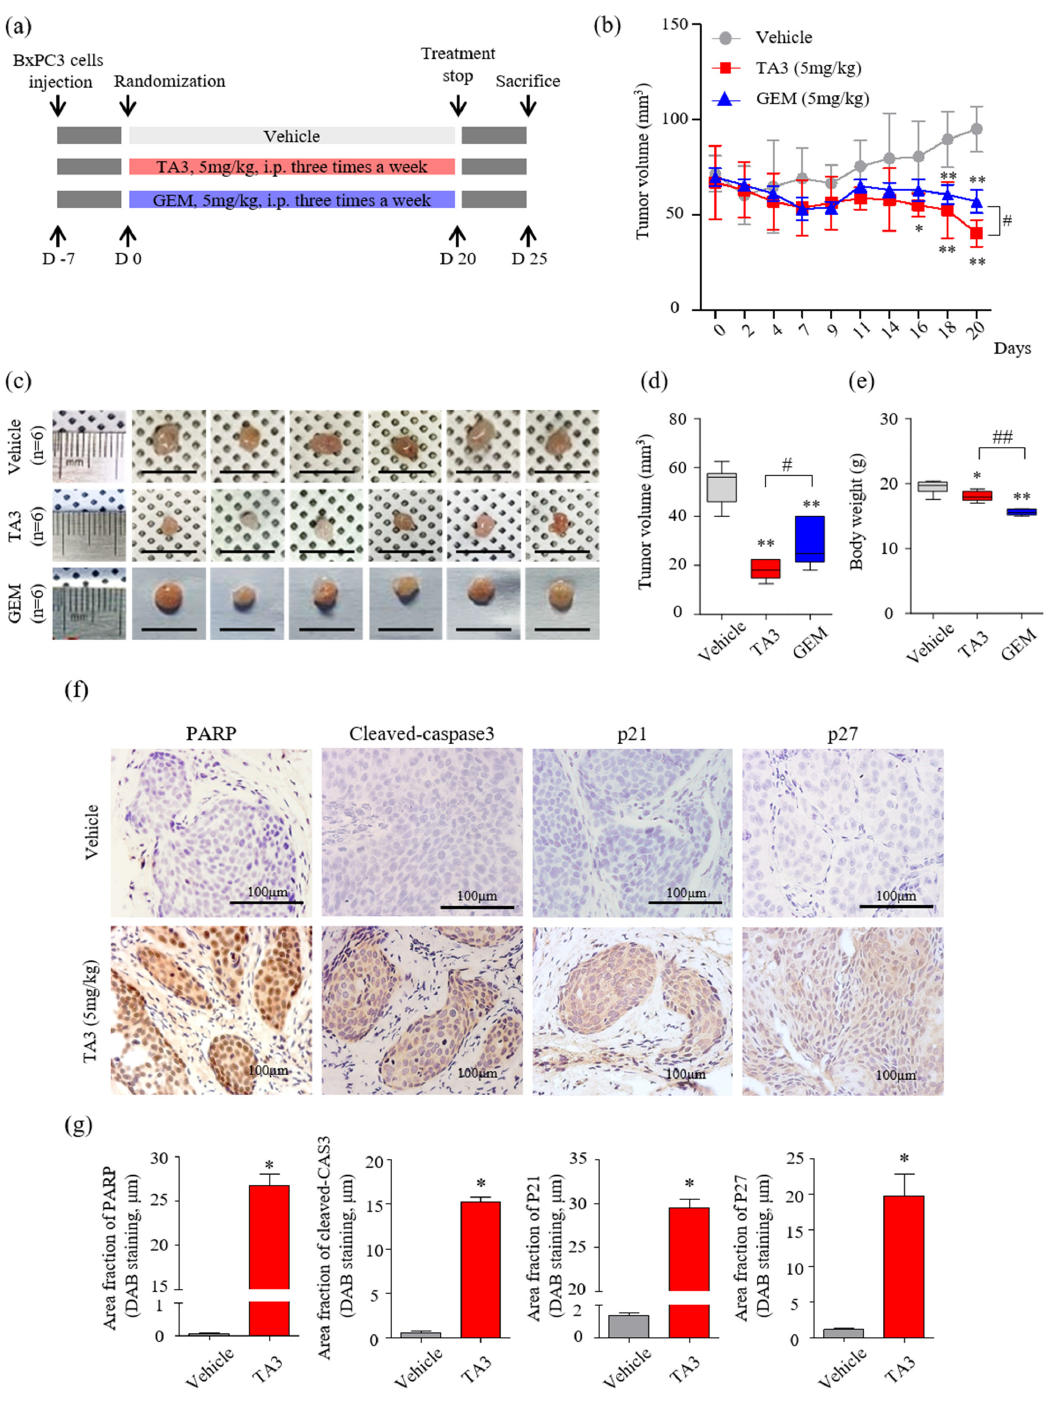
Figure 5. Effects of TA3 on pancreatic cancer growth in a xenograft mouse model. ( a ) Experimental methods of schematic representation as described in the Materials and Methods section. Briefly, BxPC-3 cells (1 × 10 7 cells/mouse) were mixed with Matrigel at a ratio of 1:1 ( v/v ) before subcutane- ous injection and randomly assigned to six mice of each group. Then, 100 µL of PBS and each drug (5 mg/kg of TA3 and GEM) were intraperitoneally injected into the mice of each group three times